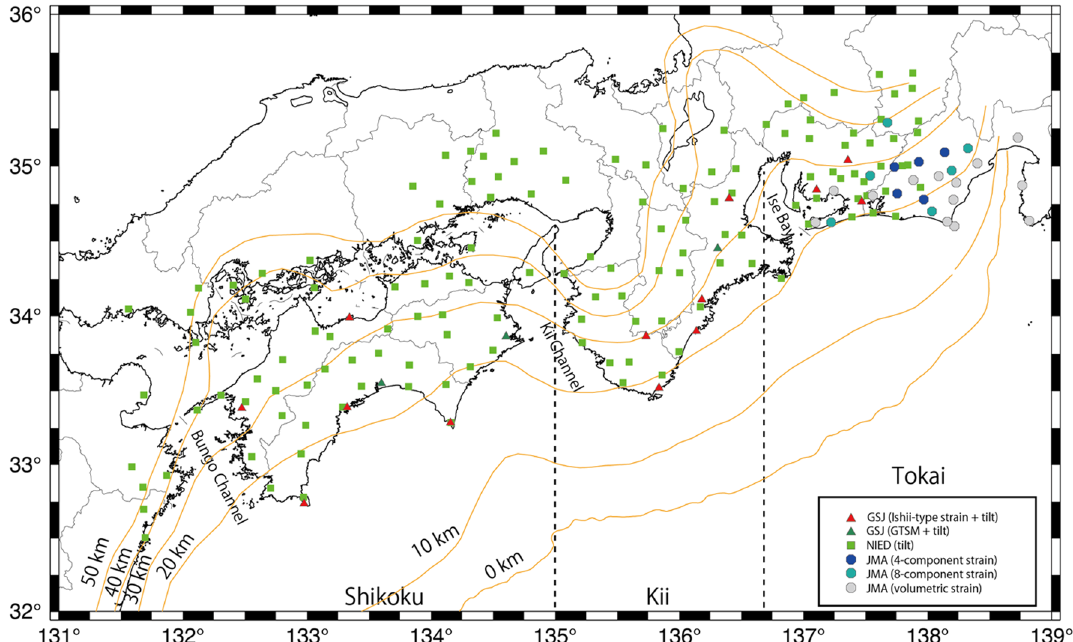
Fig. 1 Station map and tectonic settings of the southwest Japan. Red triangles are GSJ stations, where Ishii-type strainmeter and tiltmeters were deployed. Green triangles are GSJ stations, where Gladwin Tensor Strainmeter (GTSM) and tiltmeters were deployed. Green squares are NIED tiltmeters. Dark blue octagons are JMA stations, where one Ishii-type strainmeter is deployed. Light blue octagons are JMA stations, where two sets of Ishii-type strainmeters were deployed. Gray octagons are JMA stations, where volumetric strainmeters were deployed. Orange curves are the location of trench and iso-depth contours of subducting plate interface by Baba et al. (2002), Nakajima and Hasegawa (2007), and Hirose et